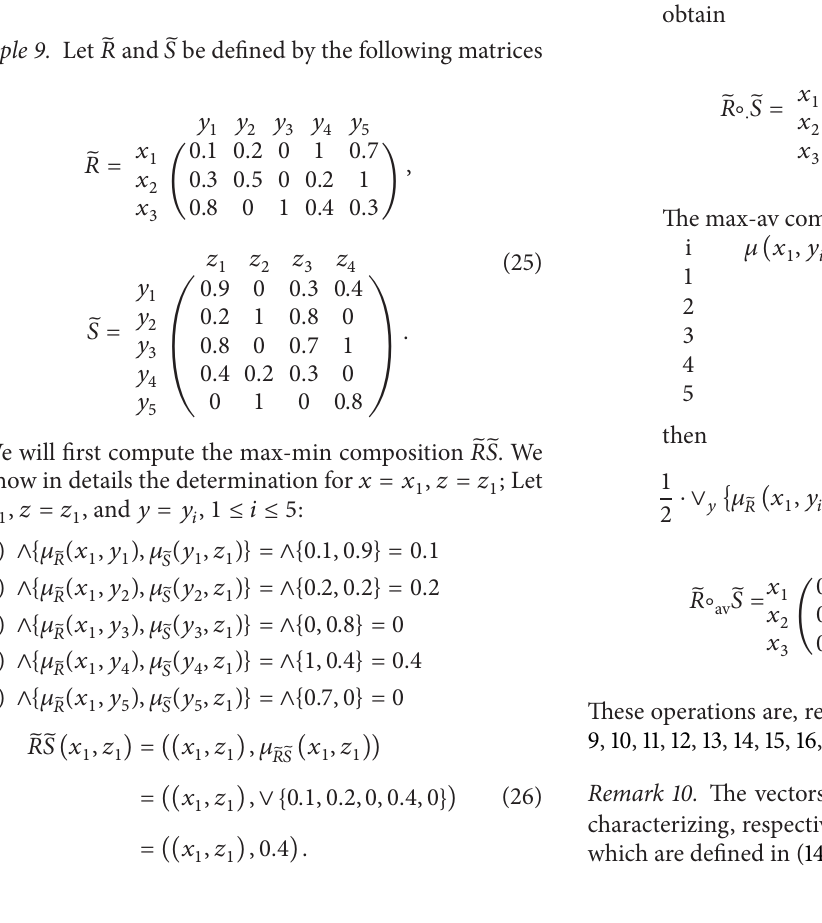
Figure 6: The max-av composition of fuzzy relations